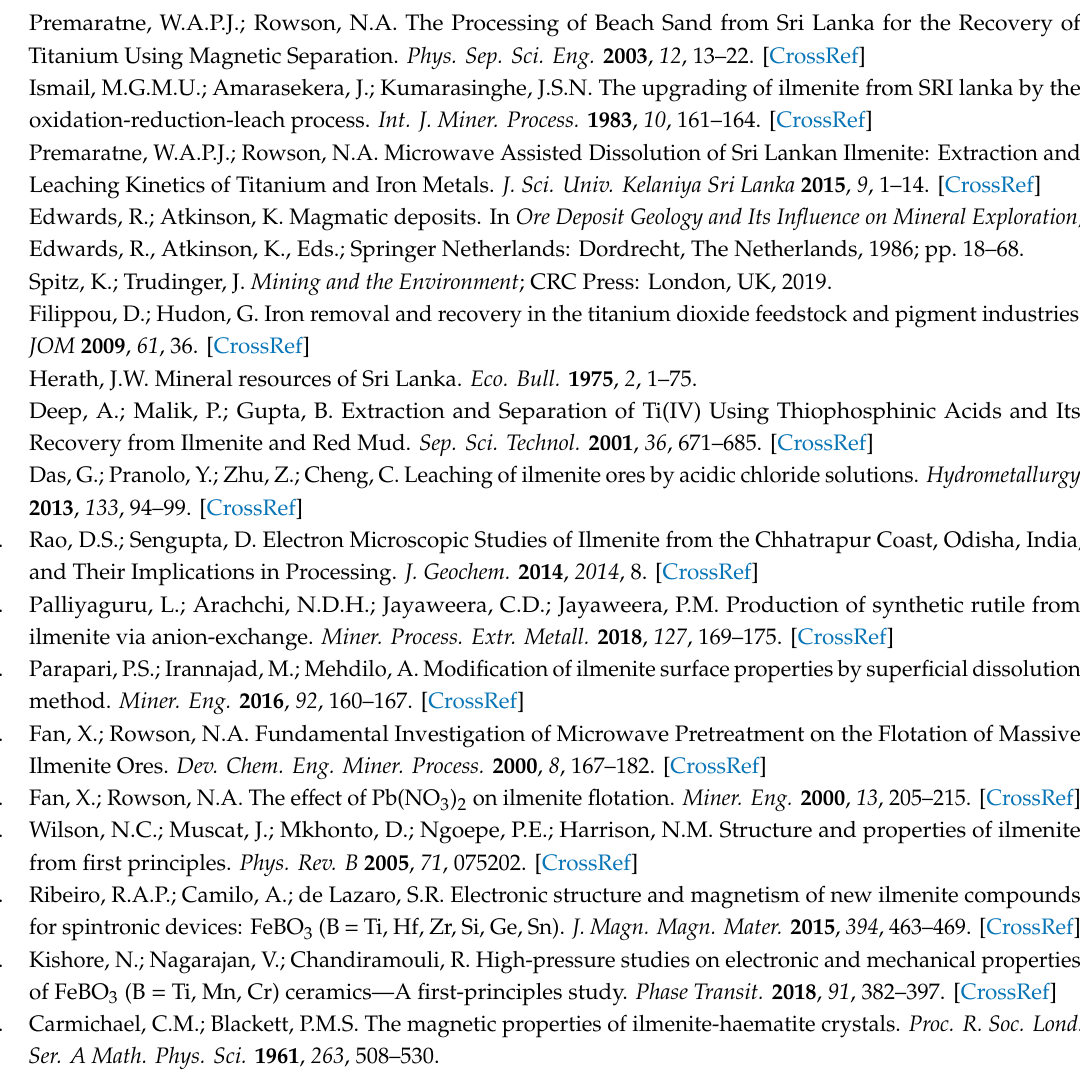
Table S1: Interatomic potential parameters used in the atomistic simulations of FeTiO 3